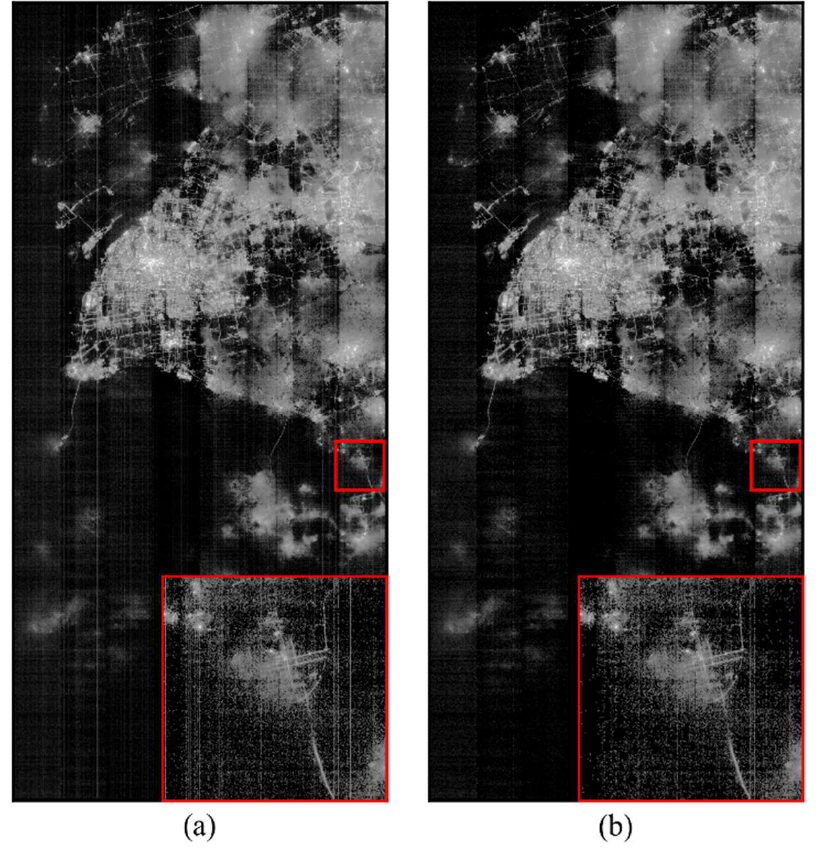
Figure 14. Destriping result of the poor-quality image based on the proposed algorithm. ( a ) Original image. ( b ) Destriped image.